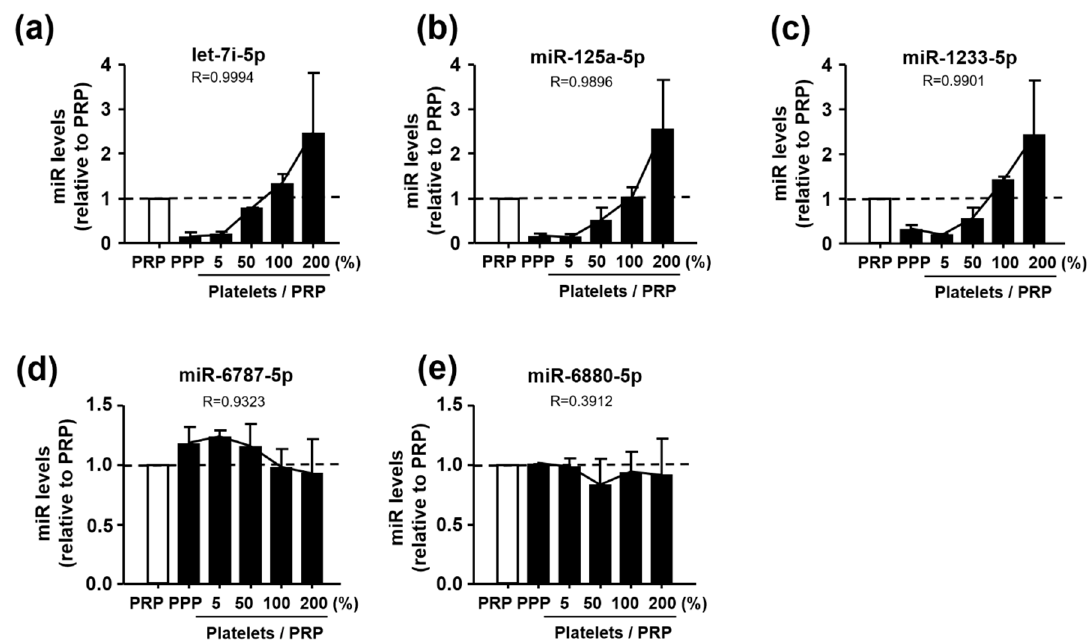
Figure 1. Levels of ( a ) let-7i-5p, ( b ) miR-125a-5p, ( c ) miR-1233-5p, ( d ) miR-6787-5p, and ( e ) miR-6880-5p in relation to the platelet-rich plasma (PRP) after spiking back platelets into the platelet-poor plasma (PPP) (0%–200%) in the platelet spike-in experiment. Data are mean ± SEM of seven experiments. R value was calculated by the Pearson’s correlation coefficient.